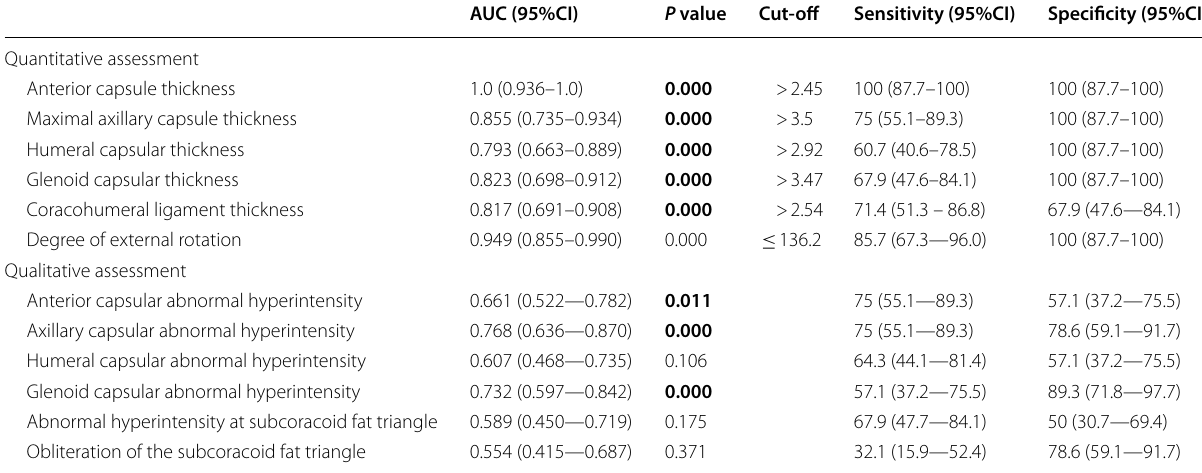
The statistically significant values were marked by bold